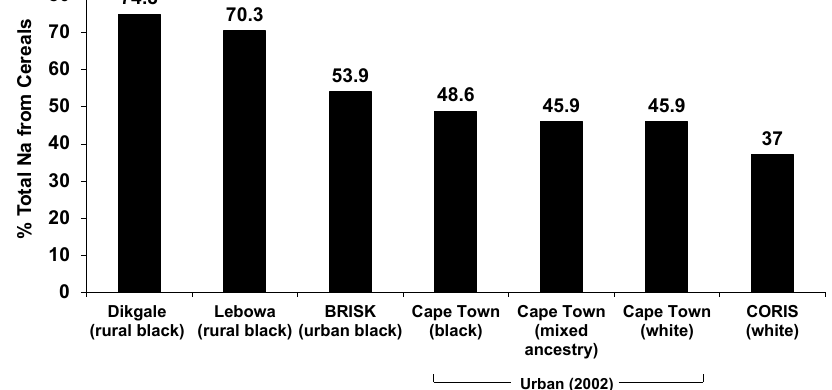
Figure 2. The contribution of the bread and cereals food group to total non-discretionary sodium intake in surveys of South African adults, by ethnic group (this figure is reprinted from Charlton, et al ., 2005 [56]. Copyright 2005, with permission from Elsevier